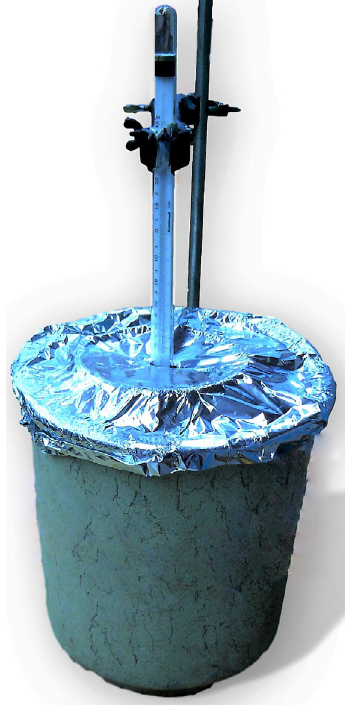
Fig. 6. View of the experimental system. Its properties are as follows. Inner pot: height – 15cm, diameter – 9cm, thickness – 6mm. Outer pot: height – 40 cm, diameter – 18cm, thickness – 6mm. We used 10kg of sand and 0.8 L of